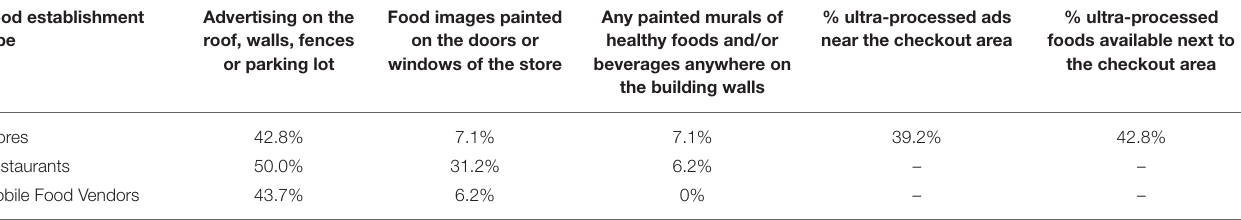
TABLE 5 | Types of advertisement used for marketing and promotion of food across surveyed food establishments ( n = 60) of Delhi National Capital Region, India. Food establishment type